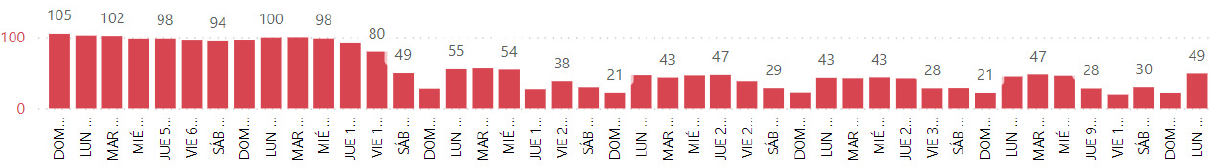
Figure 6. Percentage of daily mobility using public transport in Cartagena in March and April 2020 compared to the same days in 2019. Data source: Ministry of Transport of Spain and Cartagena City Council.